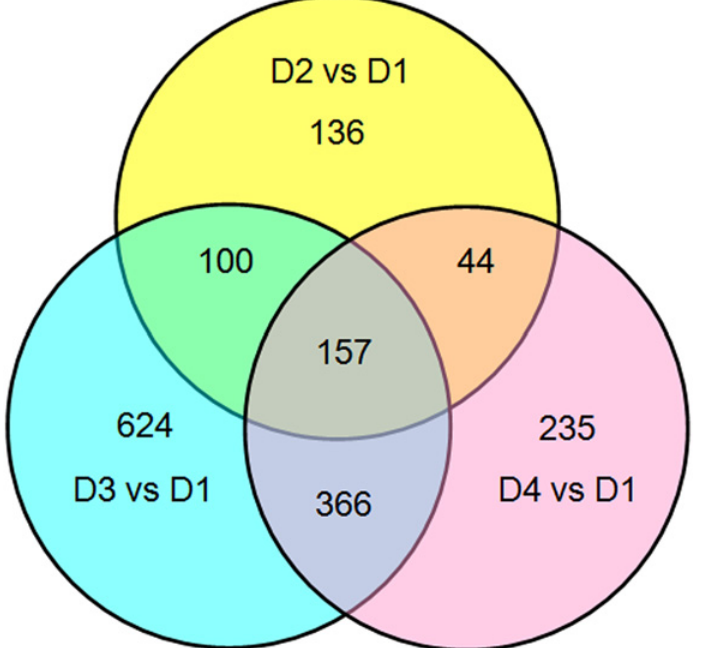
Fig 5. The Venn diagram analysis of the quantity of the 1664 DETs identified at different time points of drought treatment. One hundred and fifty-seven DETs were identified at the three time points, while some DETs were identified only at specific time-point. There were relatively large overlaps between the DETs identified at 24 h and 72 h time-points and small overlaps between the DETs identified at 1 h and 72 h time-